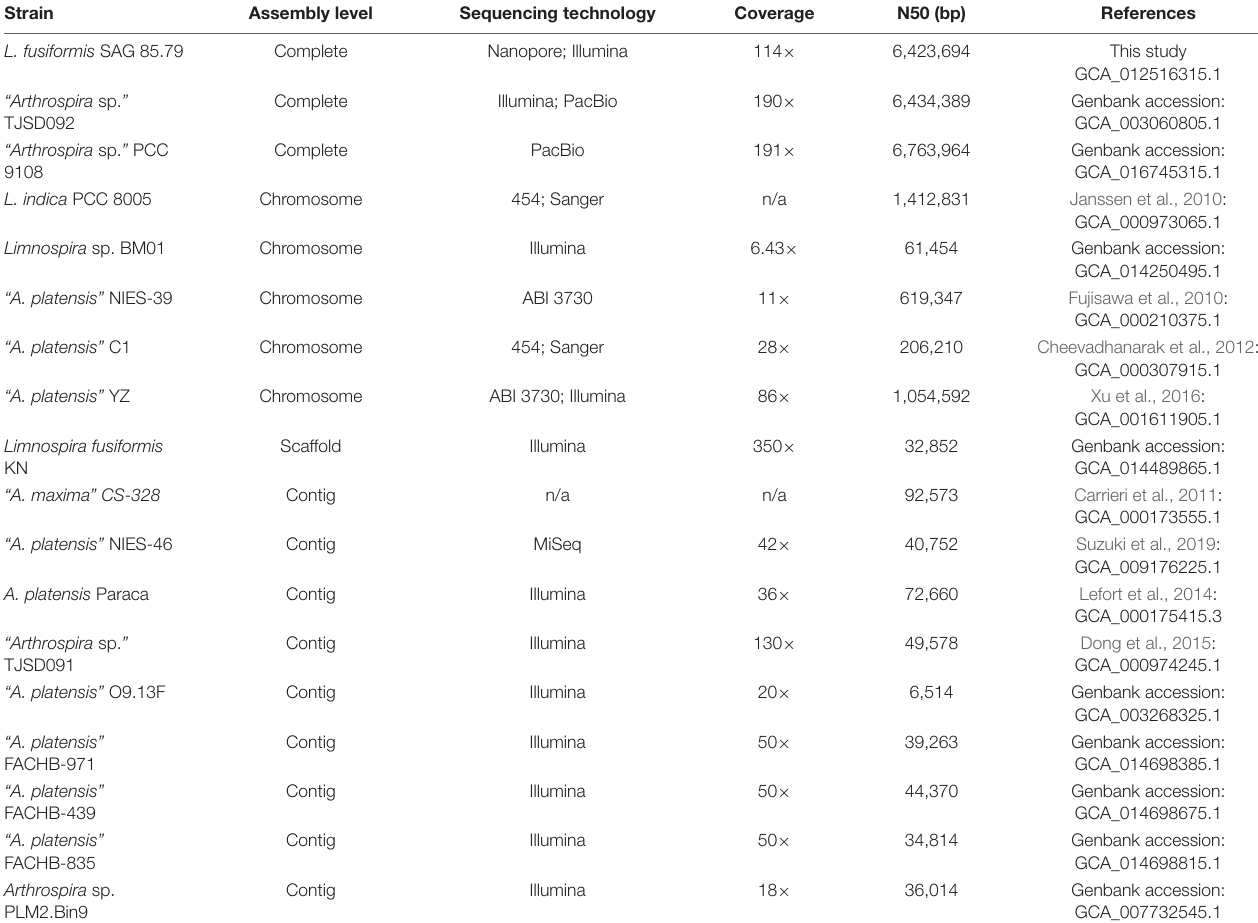
TABLE 3 | Summary of Limnospira and “ Arthrospira ” genome